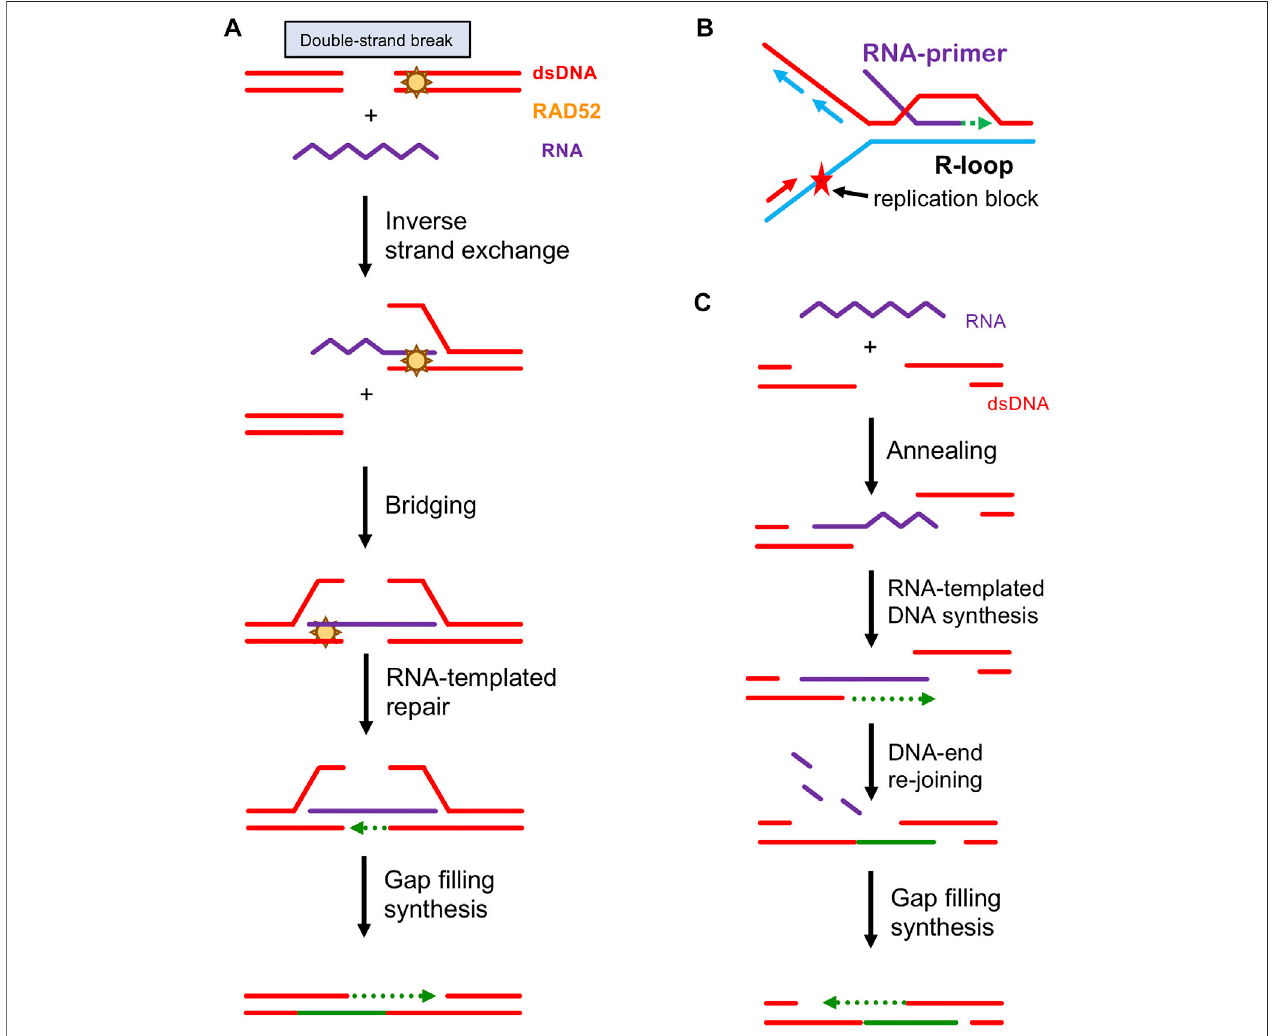
FIGURE3| ProposedMechanismsofRNA-DependentDSBRepair. (A) RepairofDSBs via inverseRNAstrandexchange.Rad52formsacomplexwithDSBends either blunt ended or minimally processed by exonucleases/helicases. Then, RAD52 promotes inverse RNA strand exchange with a homologous RNA transcript. The RNAtranscriptintheresultantDNA:RNAhybridprovidesatemplateforDNArepairsynthesis.Thesingle-strandedtailsareremovedby fl apnucleases,thegapsare fi lled in, and any remaining nicks are sealed by DNA ligases, restoring the original DNA sequence in an error-free manner. (B) Restart of DNA synthesis stalled at DNA damaged site primed by an R-loop. (C) A tentative role of RAD52 annealing activity in DSB repair. RAD52 promotes annealing between the ssDNA ends of an exonucleolytically processed DSB and homologous RNA transcript. The RNA transcript provides a template for DNA repair synthesis that extends the ssDNA end ensuring an overlap with the ssDNA of another DSB end. This is followed by re-joining of the DSB ends via ssDNA annealing, removal of DNA:RNA heteroduplex by RNase H, fi lling the gaps by DNA polymerases and sealing the nicks by DNA ligases.